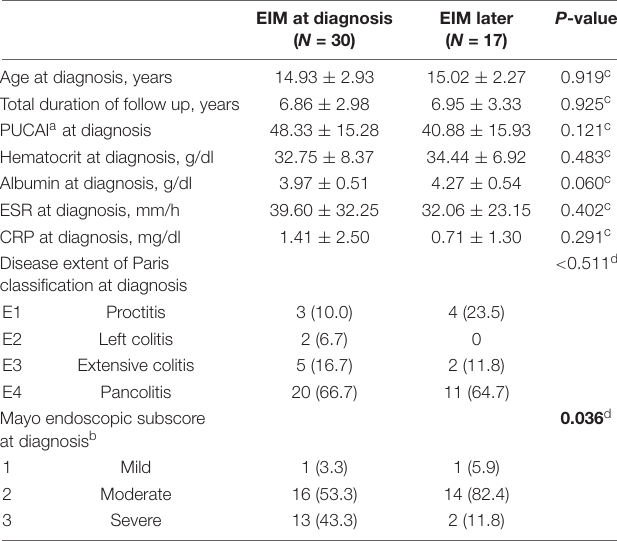
TABLE 4 | Demographic and clinical features at the time of diagnosis of the two groups; patients with EIM at the time of diagnosis and patients who had developed EIM